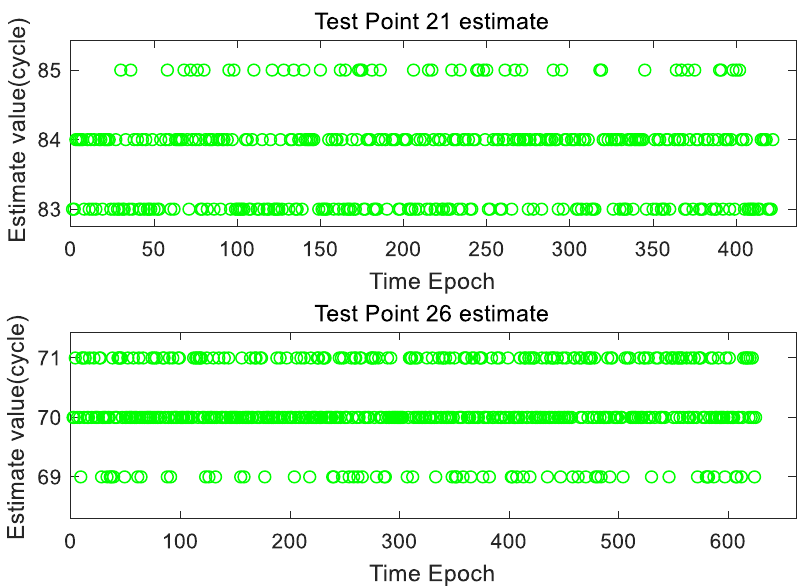
Figure 6. The estimation of carrier phase integer for two frequency points.